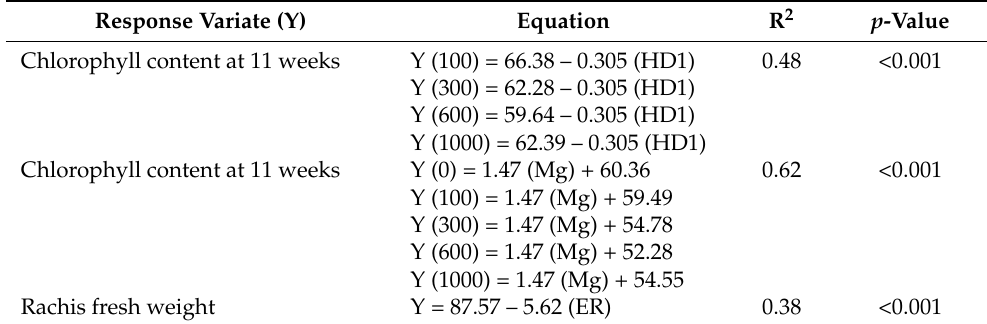
Table 4. Linear regression analysis of chlorophyll content after eleven weeks of O. lybicus infestation and rachis fresh weight with honeydew secretions in the first week, magnesium (Mg) content in leaflets and egg oviposition. (HD1) = (Honeydew 1st week), (ER) = (Eggs oviposited in rachis). Response Variate (Y) Equation R 2 p -Value Chlorophyll content at 11 weeks Y (100) = 66.38 – 0.305 (HD1) 0.48 <0.001 Y (300) = 62.28 – 0.305 (HD1) Y (600) = 59.64 – 0.305 (HD1) Y (1000) = 62.39 – 0.305 (HD1) Chlorophyll content at 11 weeks Y (0) = 1.47 (Mg) + 60.36 0.62 <0.001 Y (100) = 1.47 (Mg) + 59.49 Y (300) = 1.47 (Mg) + 54.78 Y (600) = 1.47 (Mg) + 52.28 Y (1000) = 1.47 (Mg) + 54.55 Rachis fresh weight Y = 87.57 – 5.62 (ER) 0.38